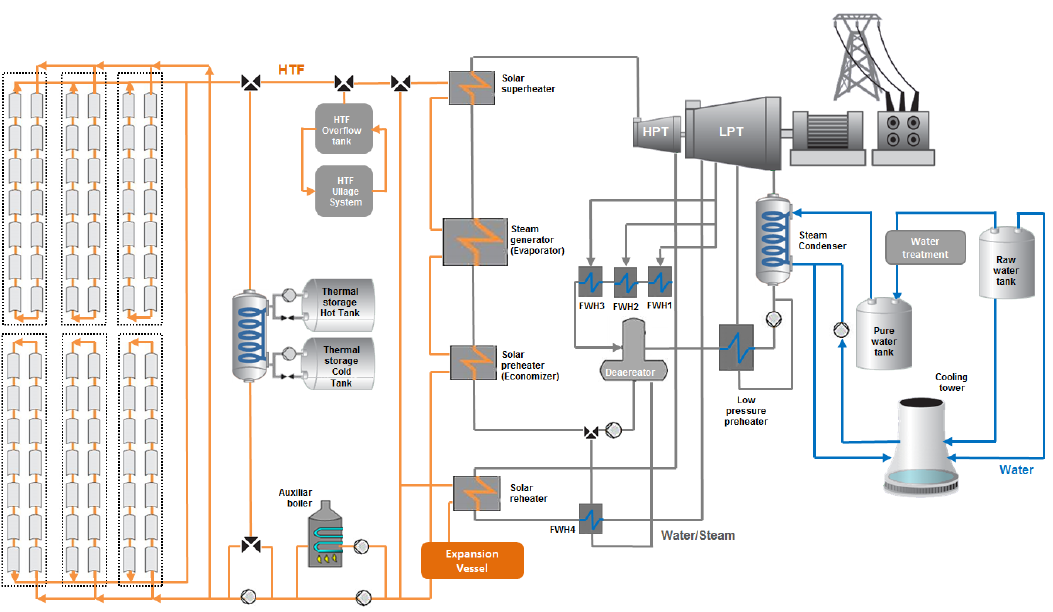
Figure 1. Parabolic trough (PT) solar-thermal power-plant implementation [26].